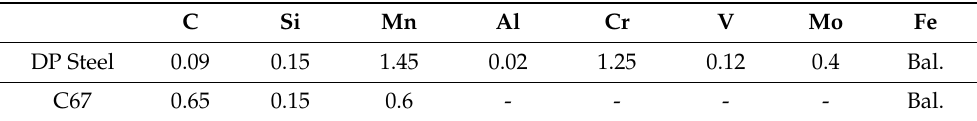
Table 1. Average chemical composition of DP steel and C67 expressed in wt% according to manufac- turer